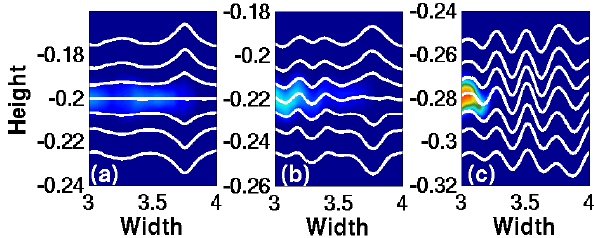
Fig. 7. A comparison of the tail behind the two largest mode-2 waves at time t = 100s for a pycnocline centred at (a) − z 0 = H/ 2, (b) − z 0 = H/ 2 + 0 . 05 H , and (c) − z 0 = H/ 2 + 0 . 20 H . Seven iso- contours of density are overlayed to depict the location of the mode- 1 waves. Notice that there are no mode-1 waves when the pycno- cline is at the mid-depth. As the pycnocline is displaced from centre, mode-1 waves quickly develop, eventually dominating the tail.